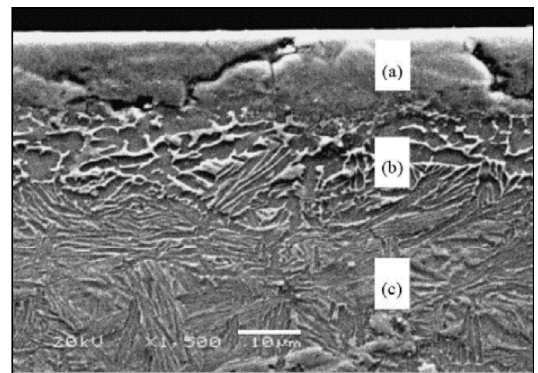
Fig. 14 SEM cross-sectional micrograph of the worn-pin Ti64 surface and sub-surface layers ((a) re-solidified layer; (b) transition layer; (c) base material). Reproduced with permission from